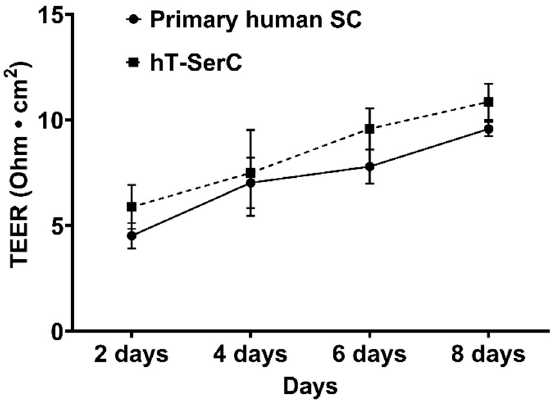
Figure 2. Transepithelial electrical resistance of primary human SCs at passages 4–6 and post-passage 20 hT-SerCs plated on 24-well Transwell inserts (0.4 µ m pore size, 0.33 cm 2 surface area) coated with 100 µ L of 6.6 µ g / mL (2 µ g / cm 2 ) human fibronectin. Resistance values were measured every two days for eight days and net resistance values for each insert were calculated by subtracting from cell-free coated inserts. TEER was calculated by multiplying the normalized resistance measurements with the surface area of the insert. Data are represented as the mean ± S.D. of three independent experiments.